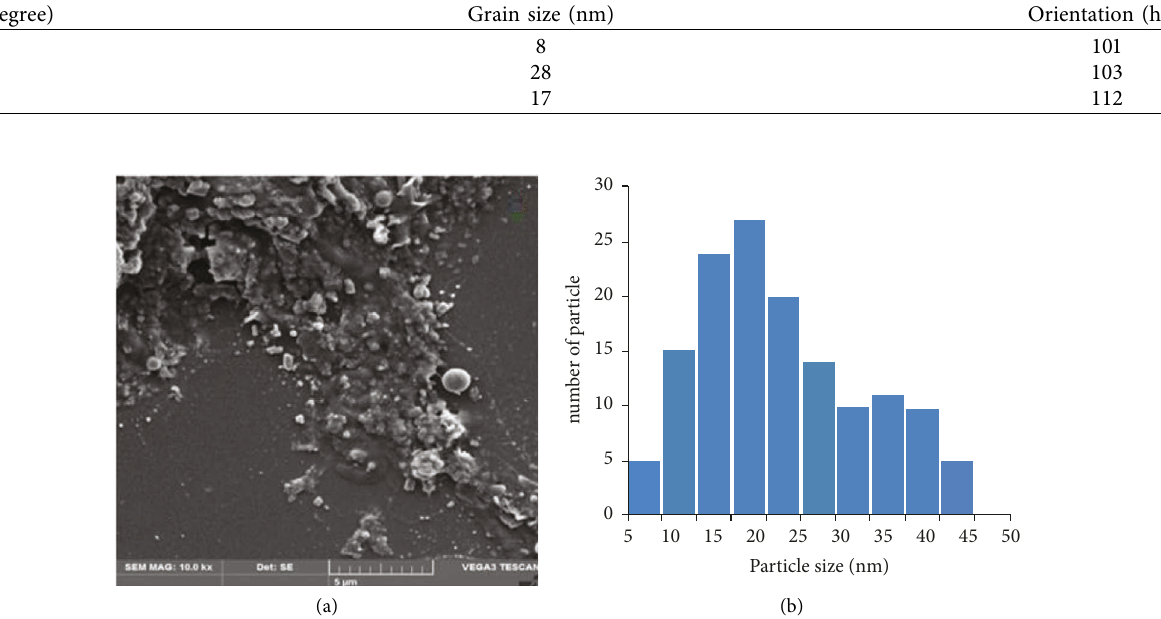
2 NPs and (b) size distribution.